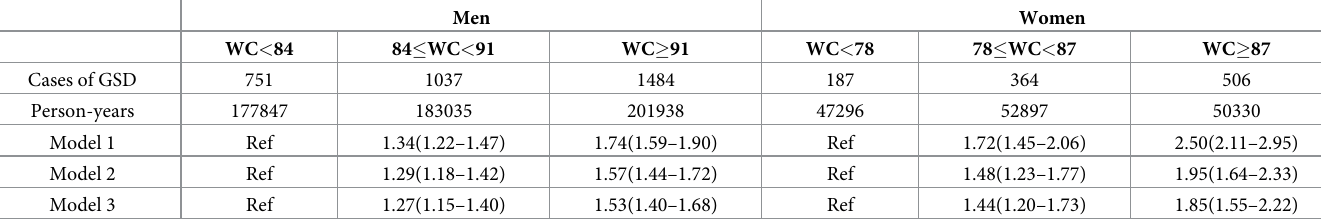
Table 3. Hazard ratios (HRs) and 95% confidence interval(CI) for risk of new-onset gallstone disease according to WC